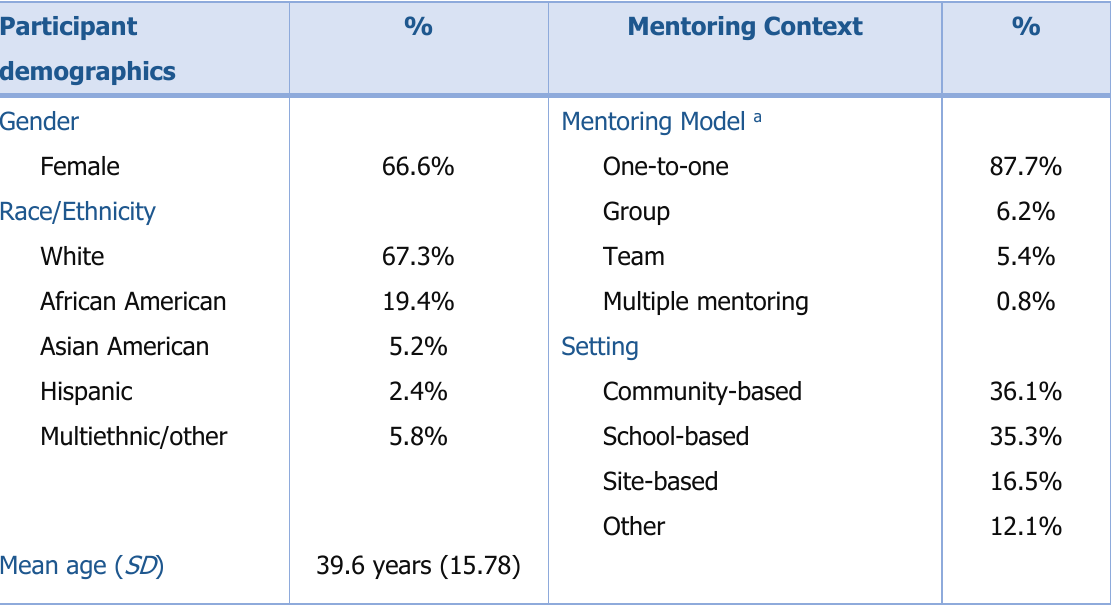
Table 2. Participant Demographics and Mentoring Context (N =